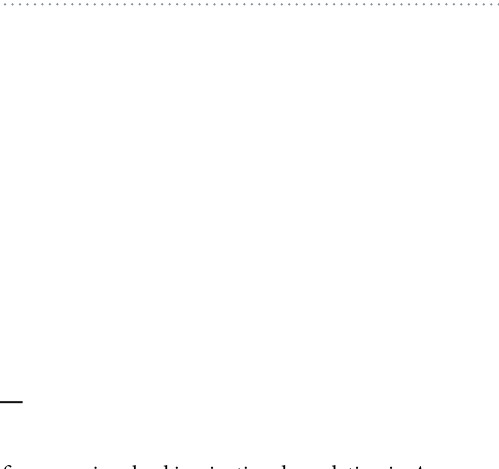
Figure 6. Gene ontology (GO) annotation of the differentially-expressed genes in A . tumefaciens S33 in glucose-ammonium medium (S33Glu) and nicotine medium (S33Nic). The differentially-expressed genes were analysed based on S33Nic VS S33Glu.